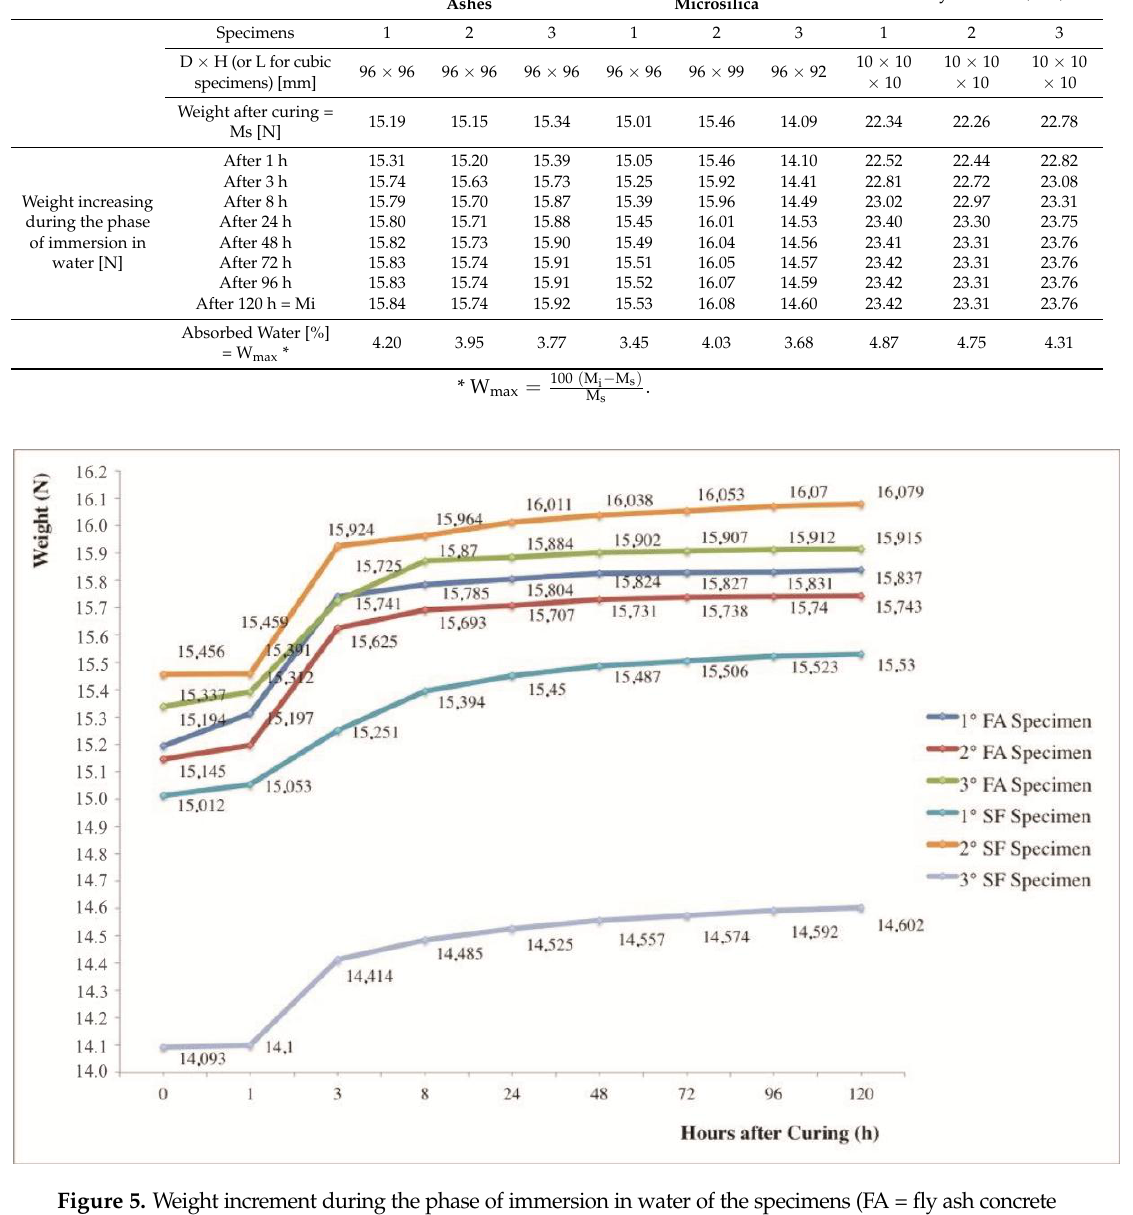
Figure 5. Weight increment during the phase of immersion in water of the specimens (FA = fly ash concrete and SF = silica fume concrete).